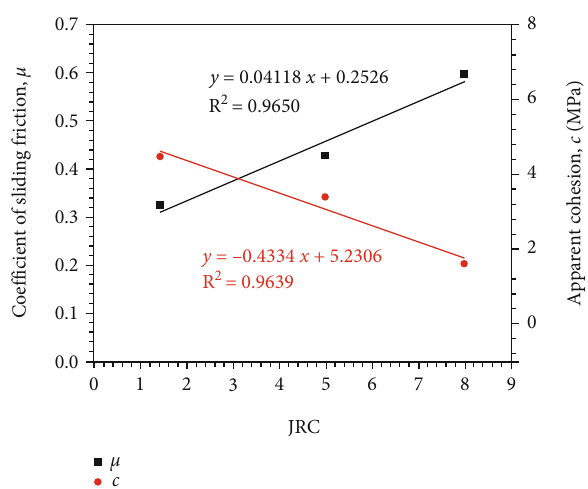
Figure 13: The relationships among JRC value, apparent cohesion, and friction coe ffi cient of test